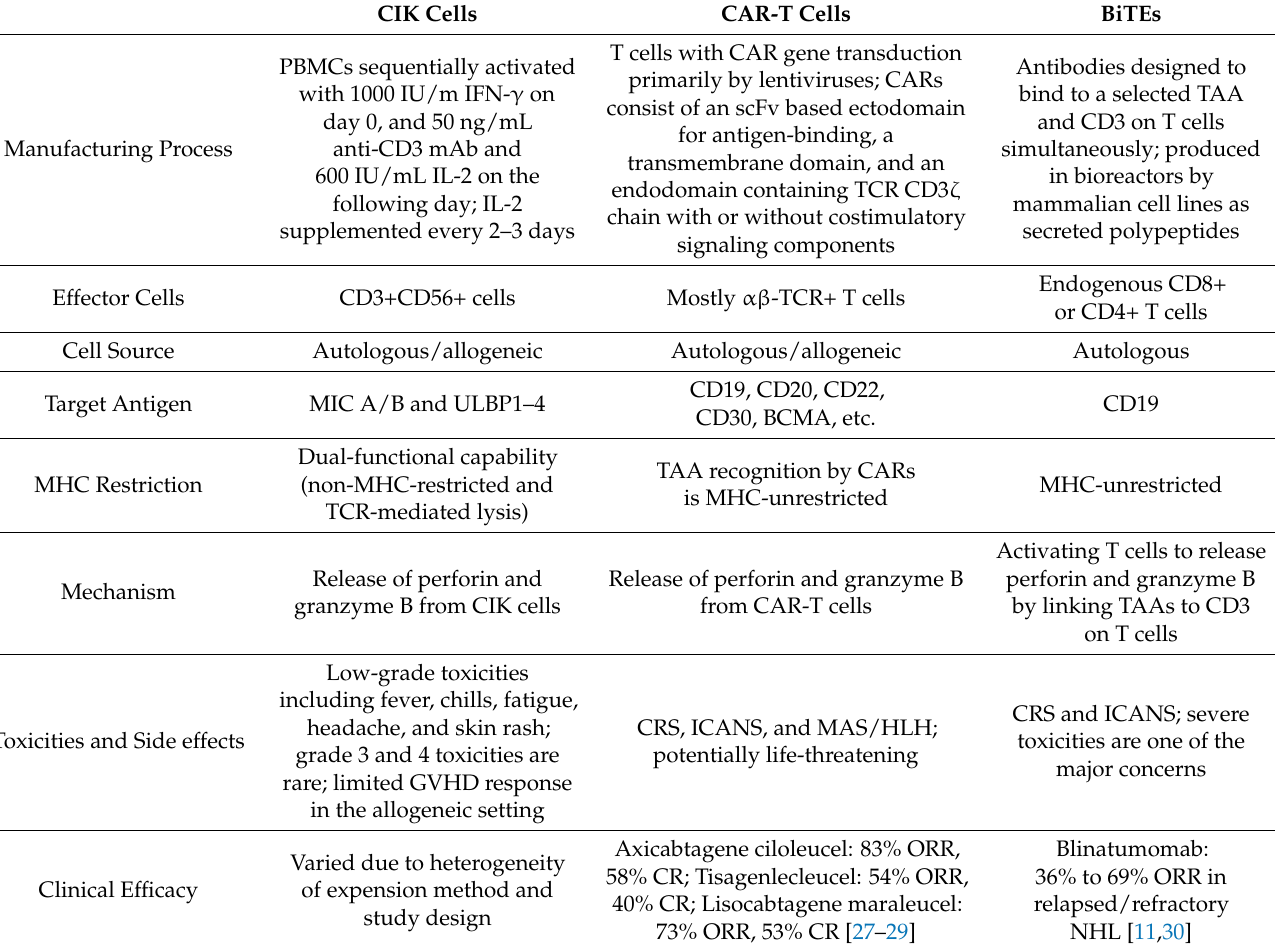
Table 1. Similarities and differences between CIK cells, CAR-T cells and BiTEs in